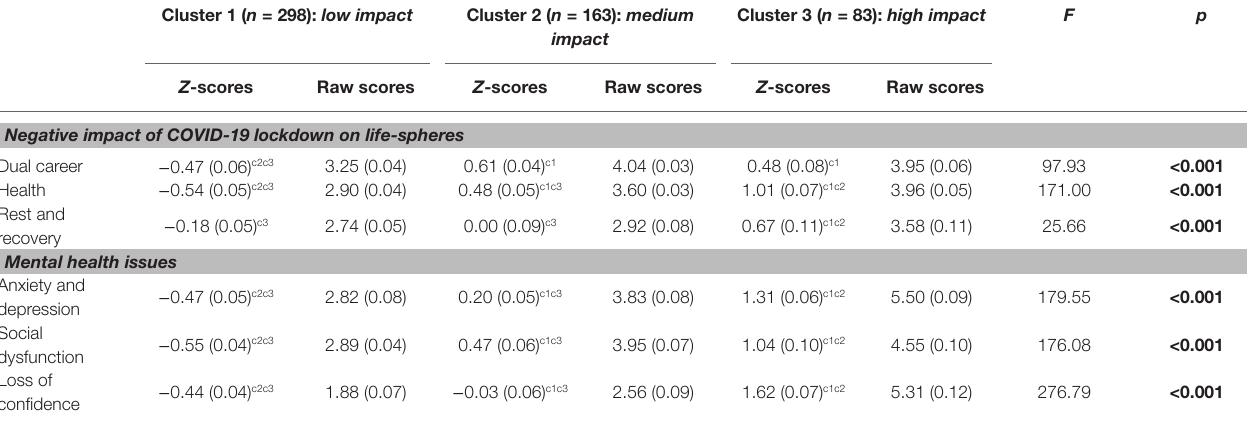
TABLE 2 | Standardized and non-standardized scores in the clustering variables of the accepted cluster solution. Cluster 1 ( n = 298): low